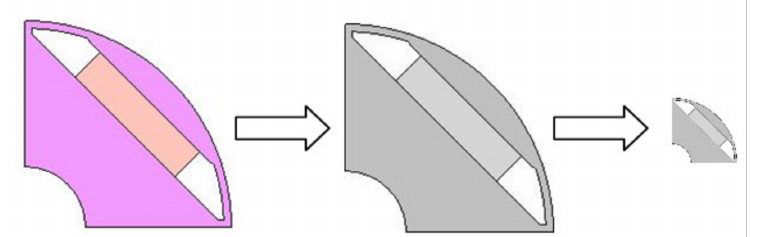
Figure 3. Preparing rotor images for convolutional neural network (CNN) training by converting to grayscale and resizing JMAG Designer exported rotor